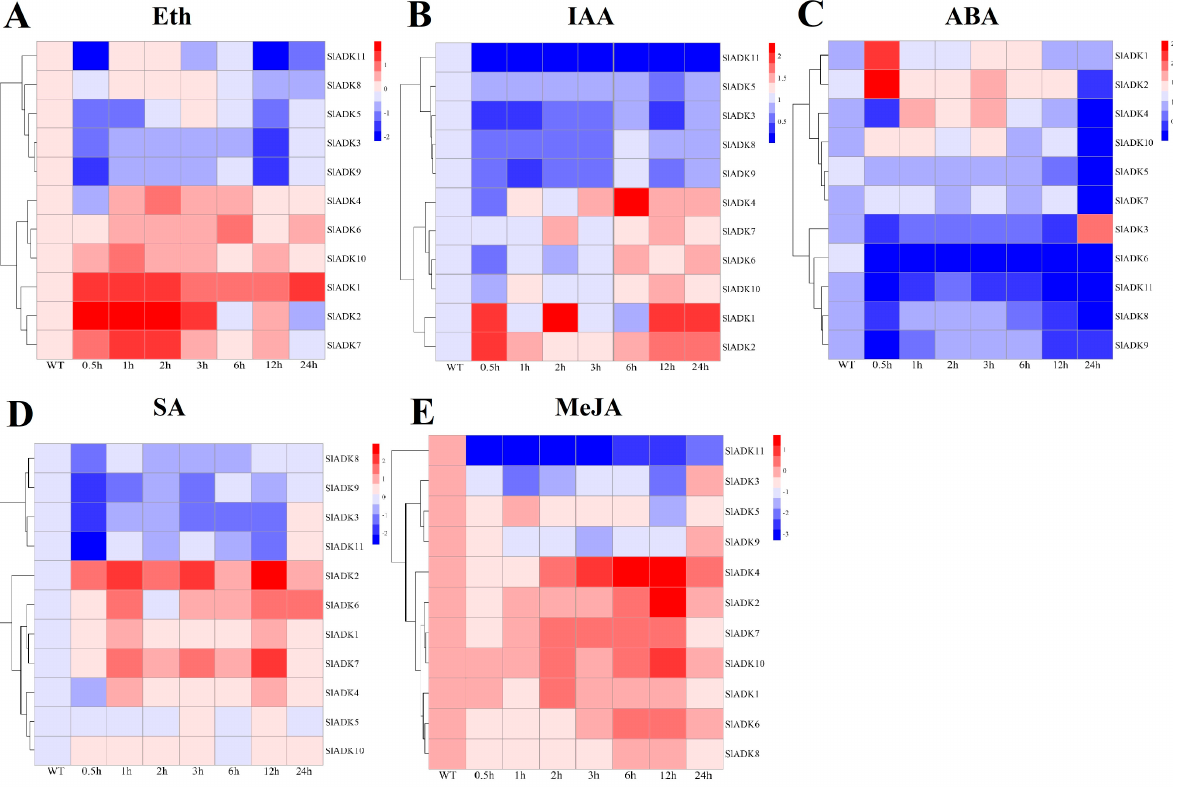
Figure 7. Expression profiles of SlADKs under various hormone treatments by qRT-PCR. The treated tomato leaves were harvested at the indicated time points. To ensure that expression of the same gene in different treatments, as well as expression of different genes in the same treatment, can both be clearly displayed and compared, for treatment with Eth ( A ), SA ( D ), and MeJA ( E ), the color scale represents log2 mean value of relative expression levels from three independent biological replicas ( n = 3); for treatment with IAA ( B ) and ABA ( C ), the color scale represents mean value of relative expression levels from three independent biological replicas ( n = 3). Primers specific for SlADK s are listed in Supplementary Materials Table S5.